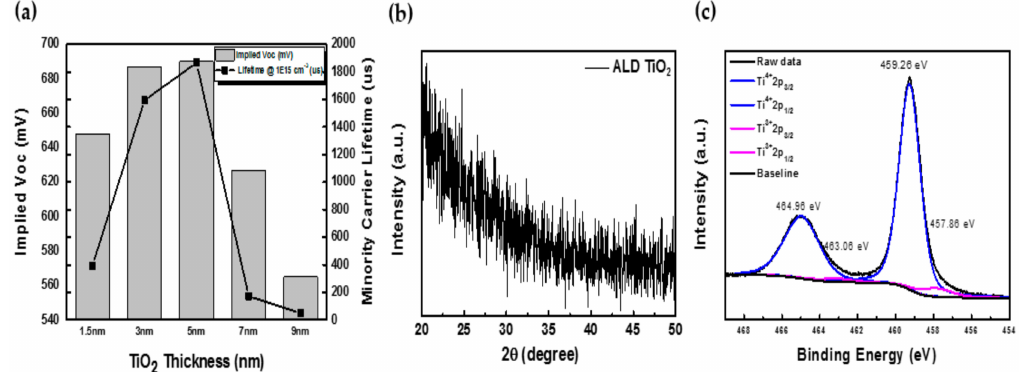
Figure 3. ( a ) Implied V oc and carrier lifetime data, ( b ) GIXRD spectra, and ( c ) Ti 2 p XPS spectra of ALD TiO 2